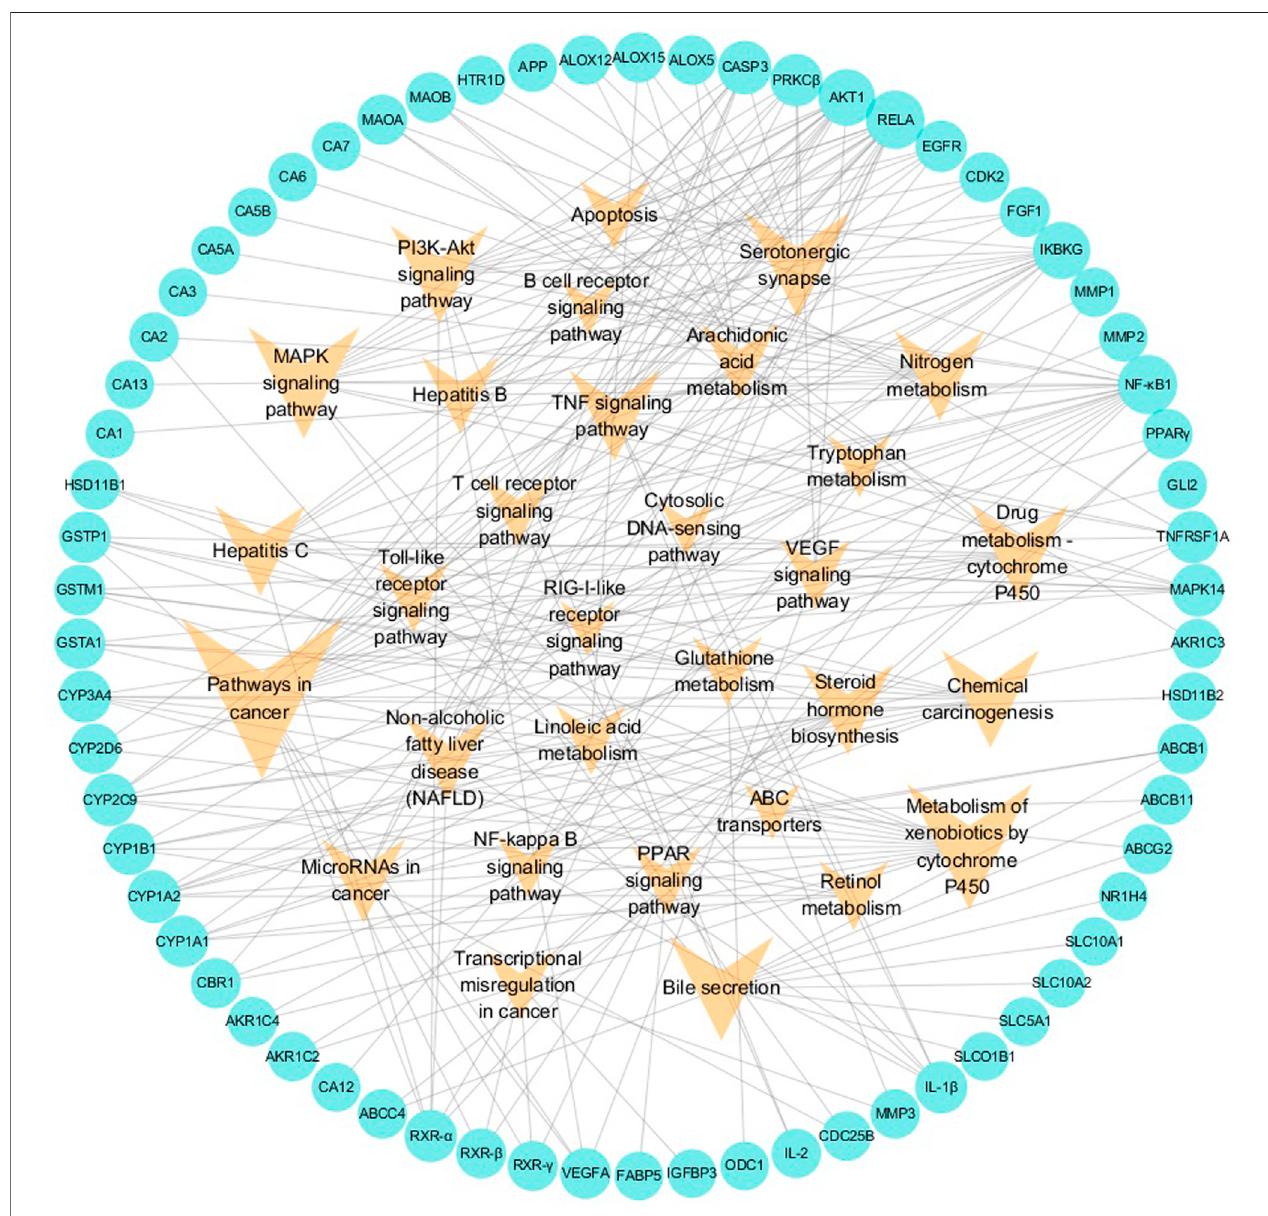
FIGURE3| Potentialtarget – pathway (pT-P) networkassociatedwithliver injurybased onthe active ingredients ofLCS. Note: the cyancircleand V-shaped nodes represent potential targets and pathways, respectively.